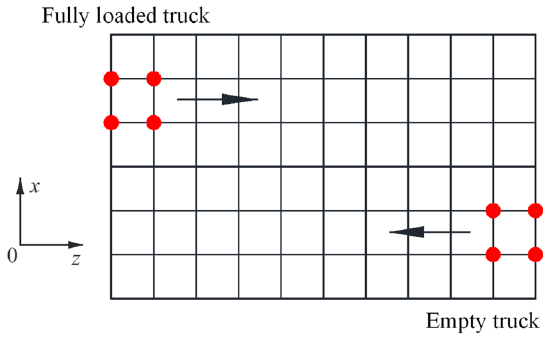
Fig. 20 Schematic diagram of mesh division and dynamic load appli- cation of haulage bench